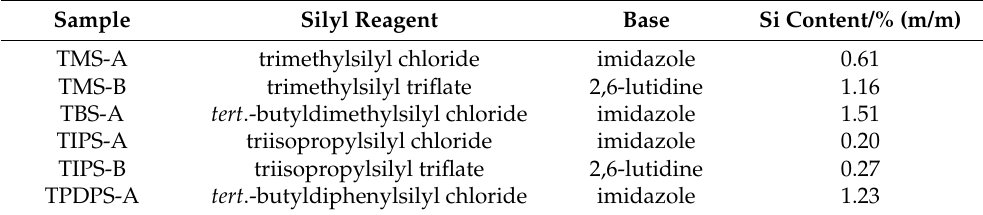
Table 1. Summary of reagents employed in the silylation of RF xerogels and resulting silicon content.